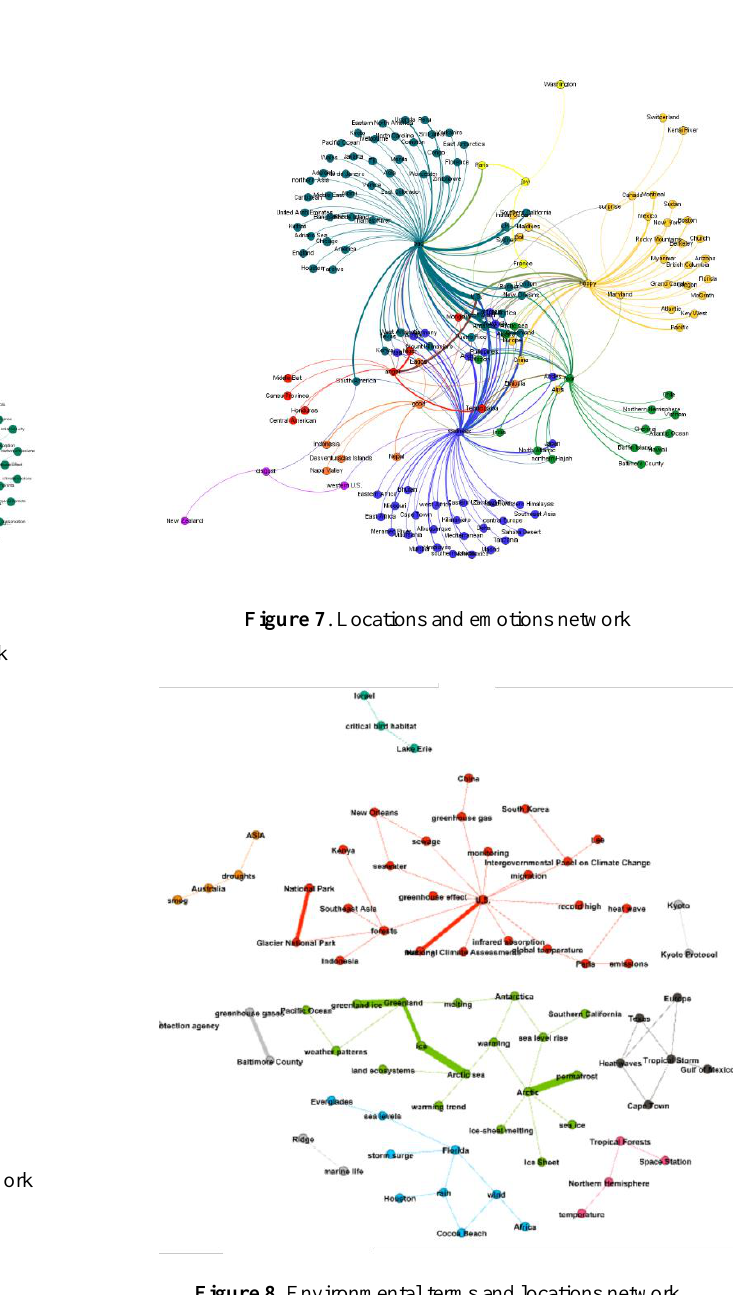
Figure 8 . Environmental terms and locations